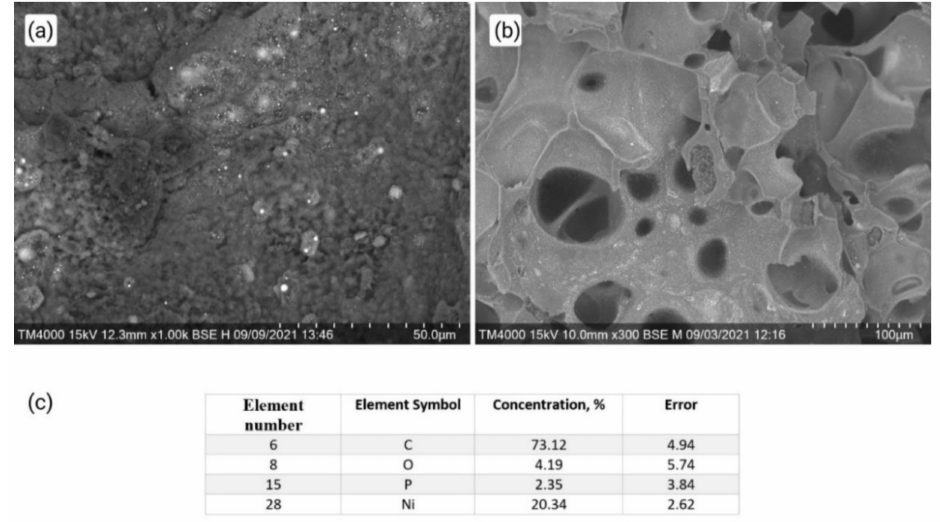
Figure 5. SEM images ( a , b ) and elemental analysis from energy dispersive X-ray spectrometry ( c ) for an object 3D-printed from the commercial photopolymer resin Harz Labs with concentration of ZIF-8 and Ni-BTC 5 wt.% and 5 wt.%, respectively.